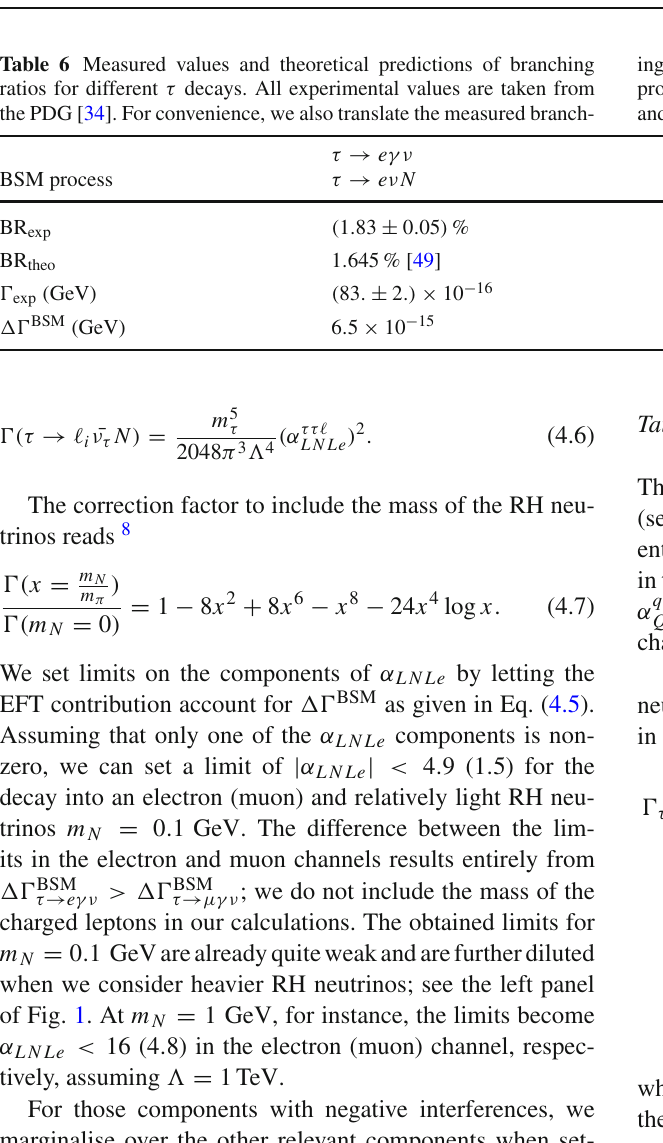
translate the measured branching ratio into decay width and list the allowed contribution from BSM processes according to Eq. (4.5)